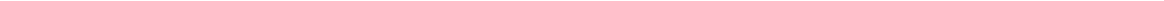
Fig. 6. Aulonotreta neptuni sp. nov., all from the lower Darriwilian Kunda Stage ( Asaphus raniceps Zone). A , NRM-PZ Br14925, slightly exfoliated, fragmented dorsal exterior, Hälludden, northern Öland, Sweden. B , NRM-PZ Br20075, latex cast internal mould of fragmented dorsal interior, Hälludden, northern Öland, Sweden. C , NRM-PZ Br14920, slightly exfoliated, fragmented dorsal exterior, Hälludden, northern Öland, Sweden. D , NRM-PZ Br14934, posterior view of slightly exfoliated, fragmented dorsal exterior, Torp, northern Öland, Sweden. E , SGU9920, lateral view of almost completely exfoliated complete articulated shell, Hälludden, northern Öland, Sweden. F , NRM-PZ Br20908, latex cast of ventral internal mould, Byrum, northern Öland, Sweden. G , NRM-PZ Br20121, fragmented ventral interior, Hälludden, northern Öland, Sweden. H , SGU9919 (Holotype), lateral view of a fragmentary ventral interior, Hälludden, northern Öland, Sweden. I , NRM-PZ Br2019, latex cast of dorsal internal mould, Hälludden, northern Öland, Sweden. J , detail of lateral view of H, showing visceral area. K , detail of lateral view of H, showing pseudointerarea and posterior part of visceral area. L , NRM-PZ Br18408, fragmented dorsal interior, Enerum, northern Öland, Sweden. M – O , NRM-PZ Br14938, fragmented dorsal exterior, Hälludden, northern Öland, Sweden: M, lateral view of exterior, showing contact between two rugose lamellae; N, detail of M, showing partly exfoliated rugose primary layer and location of O; O, detail of rhomboid